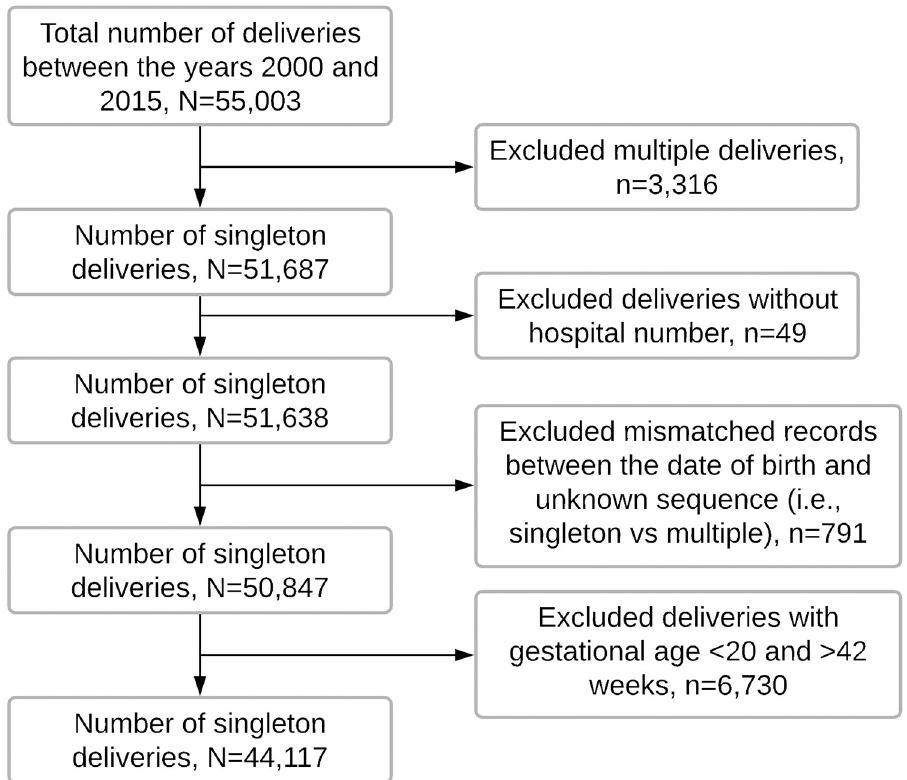
Fig 1. Flow chart showing the number of deliveries analyzed in this study. Data from the KCMC Medical Birth registry, 2000-2015.